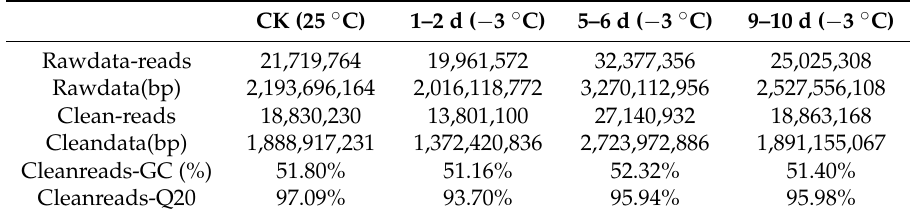
Table 1. Basic statistics of RNA-seq reads obtained from Illumina HiSeq-2000.